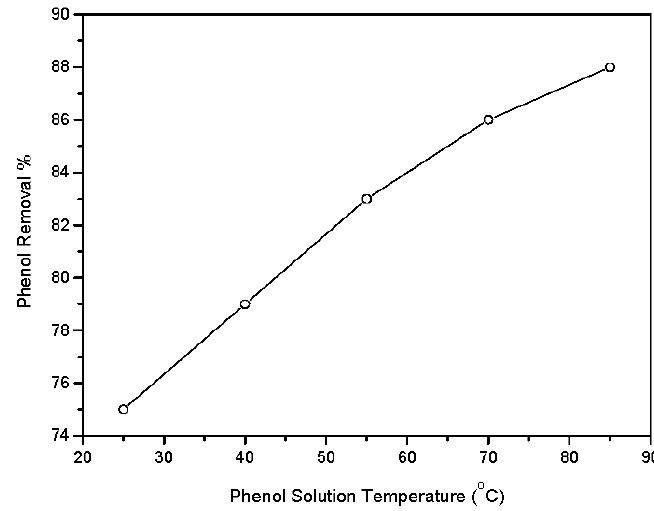
Figure 9. Influence of phenol solution temperature on the percentage of phenol removal on to magnetic ZnO nanotubes (initial phenol concentration = 10 ppm, material dosage = 4 g/L, agitation speed = 440 rpm, contact time = 90 min and pH = 5).